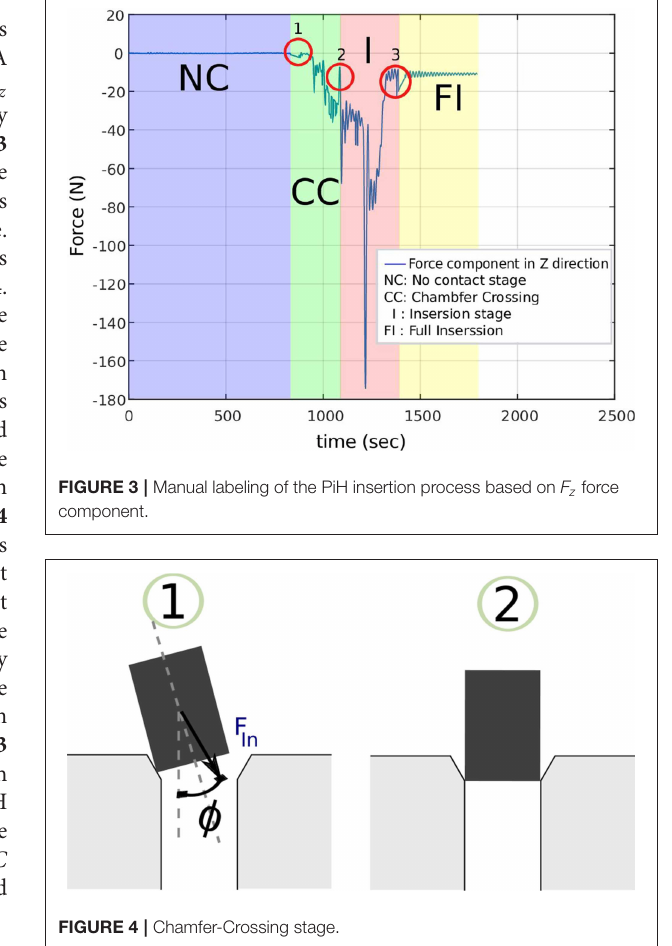
FIGURE 4 | Chamfer-Crossing